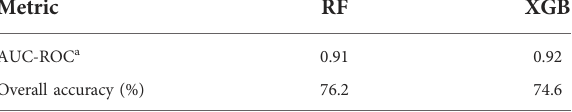
TABLE 3 Results of multiclass classi fi cation. Metric